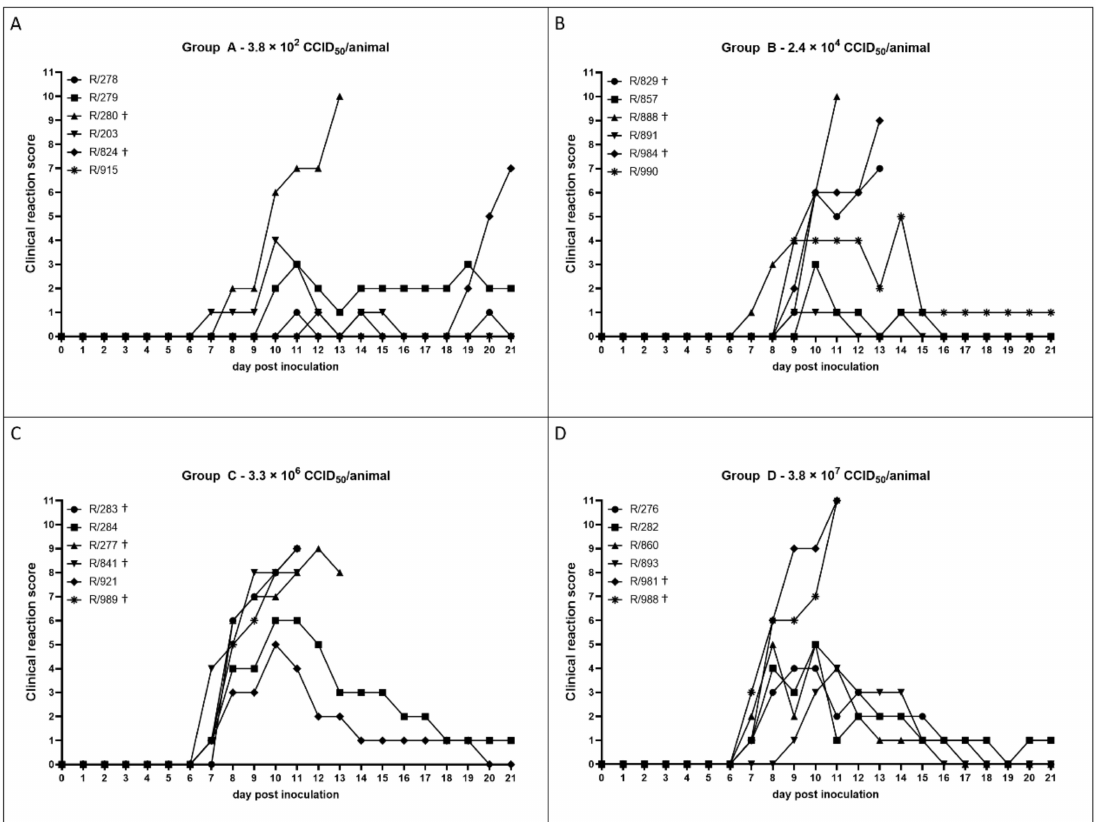
Figure 1. Clinical reaction score of cattle inoculated with di ff erent amounts of infectious Lumpy Skin Disease virus (LSDV)-“Macedonia2016”. Clinical reaction score (CRS) was measured daily from 0 dpi until 21 dpi for the di ff erent inoculation groups. CRS = 0 means no clinical signs, CRS 1–5 displays mild clinical course, and CRS 6–10 shows severe clinical reaction. Cattle with a clinical score of ≥ 10 were euthanized due to ethical reasons. ( A ) CRS of cattle inoculated with 3.8 × 10 2 CCID 50 / animal. ( B ) CRS of cattle inoculated with 2.4 × 10 4 CCID 50 / animal. ( C ) CRS of cattle inoculated with 3.3 × 10 6 CCID 50 / animal. ( D ) CRS of cattle inoculated with 3.8 × 10 7 CCID 50 / animal. † displays euthanasia of the respective animal before the end of the